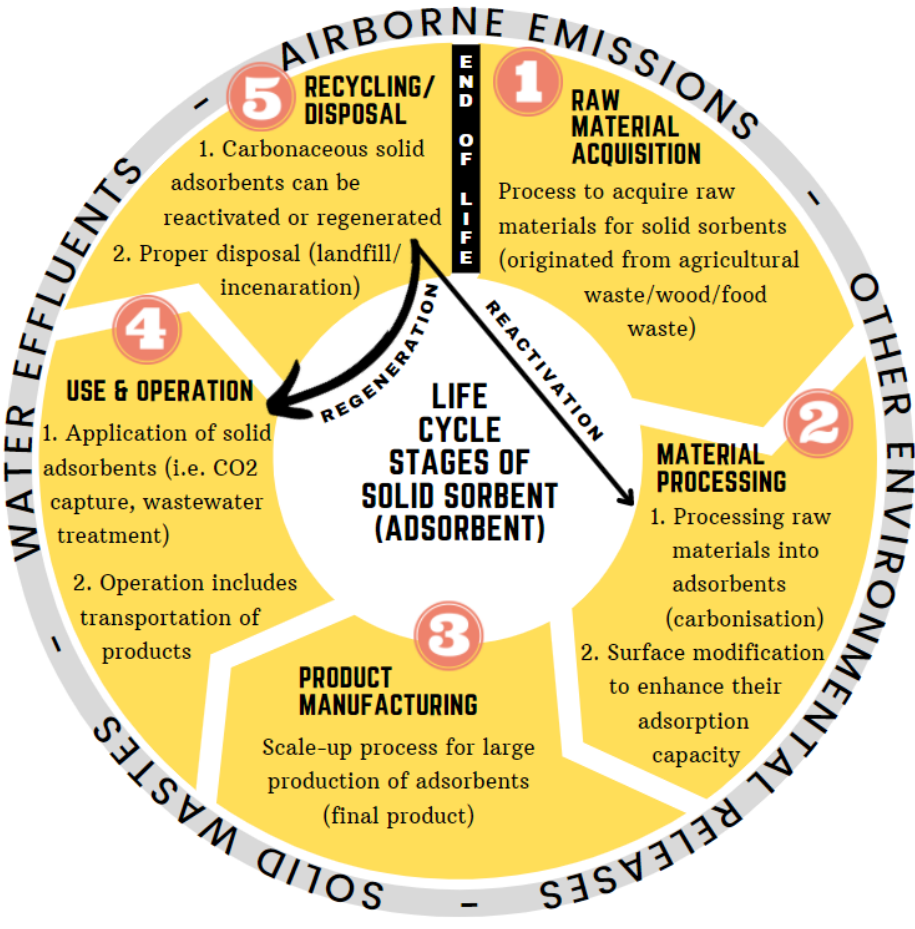
Figure 10. Life cycle assessment framework of adsorbent involving five main stages.